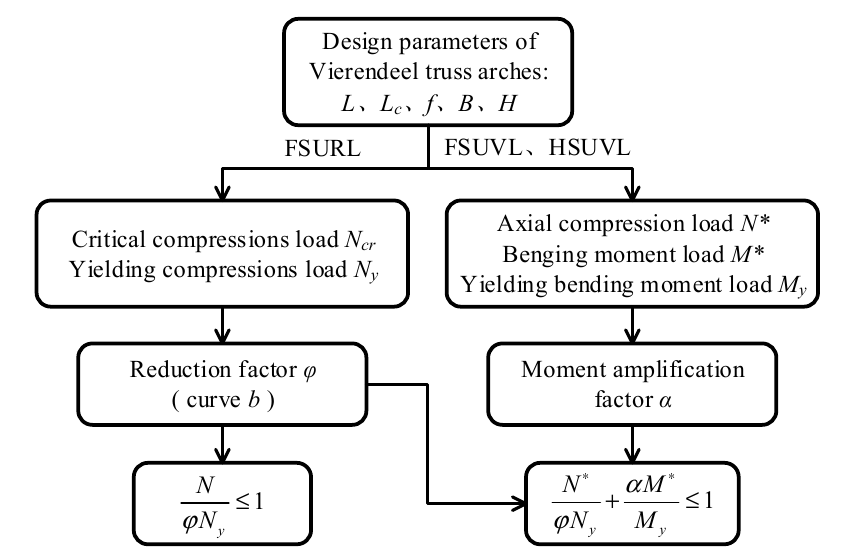
Figure 21. Out-of-plane stability design procedure of the Vierendeel truss arches.